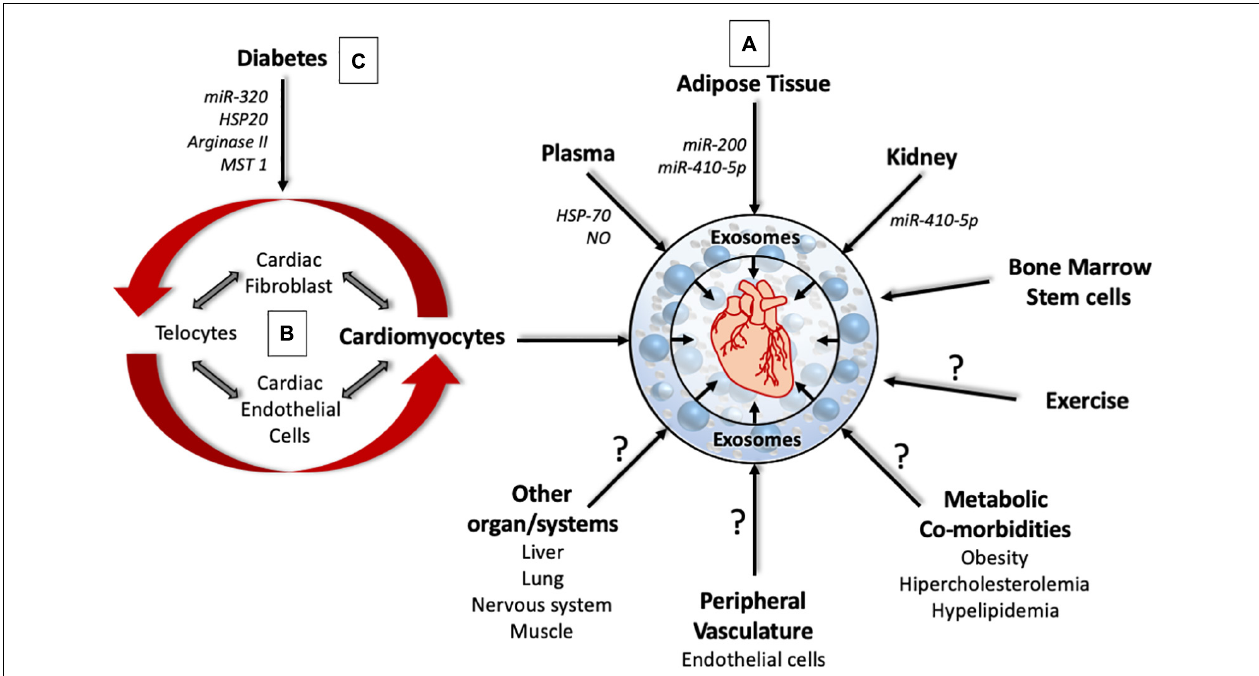
FIGURE 1 | The complex role of cardiac and non-cardiac derived exosomes in cardiac pathophysiology. (A) Exosomes from different organs affect the pathophysiology of the heart through the delivery of signaling molecules, micro-RNA and enzymes. However, the role of exosomes derived from the liver, lung, muscle, nervous system, metabolic co-morbidities, and exercise that can affect heart health are yet to be determined. (B) Exosomes from different cell types within the heart can program cells within the heart to promote cardiac remodeling that affect heart structure and function. (C) Under Diabetic milieu, exosomes from different cell types within the heart can bring about coronary endothelial dysfunction, cardiac hypertrophy, and cardiac fibrosis.